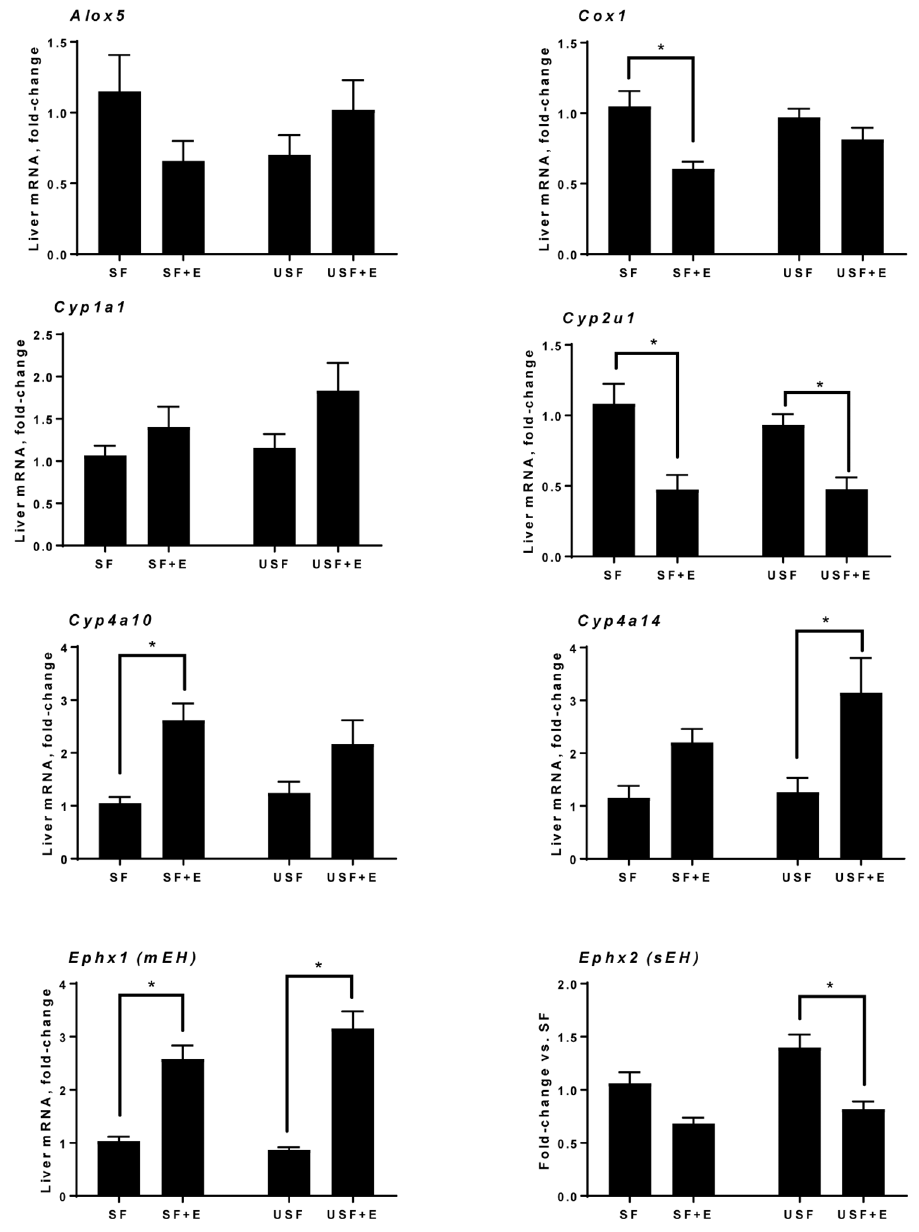
Fig 9. Analysis of the expression of genes involved in hepatic oxylipin production. Data are presented as the mean ± SEM vs. the SF group, two-way ANOVA, (cid:3) P < 0.05, n = 6 animals per group.